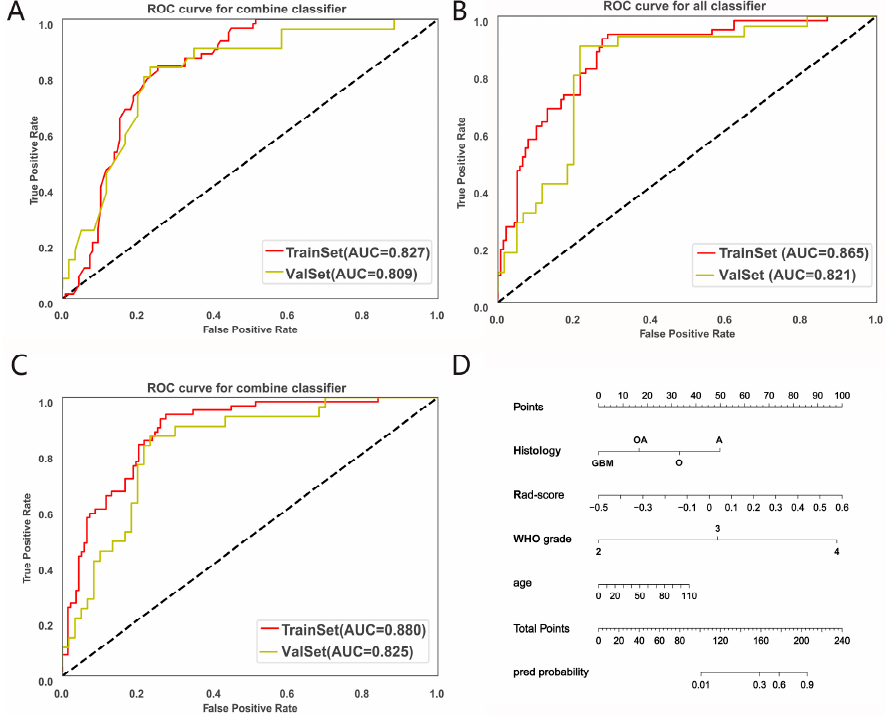
Figure 3. Establishment and validation of the predictive model of CDKN2A/B homozygous deletion in glioma. ( A – C ): The receiver operating characteristic results of the models. ( A ) clinical model, ( B ) radiomics model, ( C ) the combined clinical and radiomics comprehensive prediction model. ( D ) Nomogram of the combined prediction model of CDKN2A/B homozygous deletion: the relevant clinical characteristics and rad-score were included in the nomogram, and the results showed that rad-score correlated most strongly with the model.